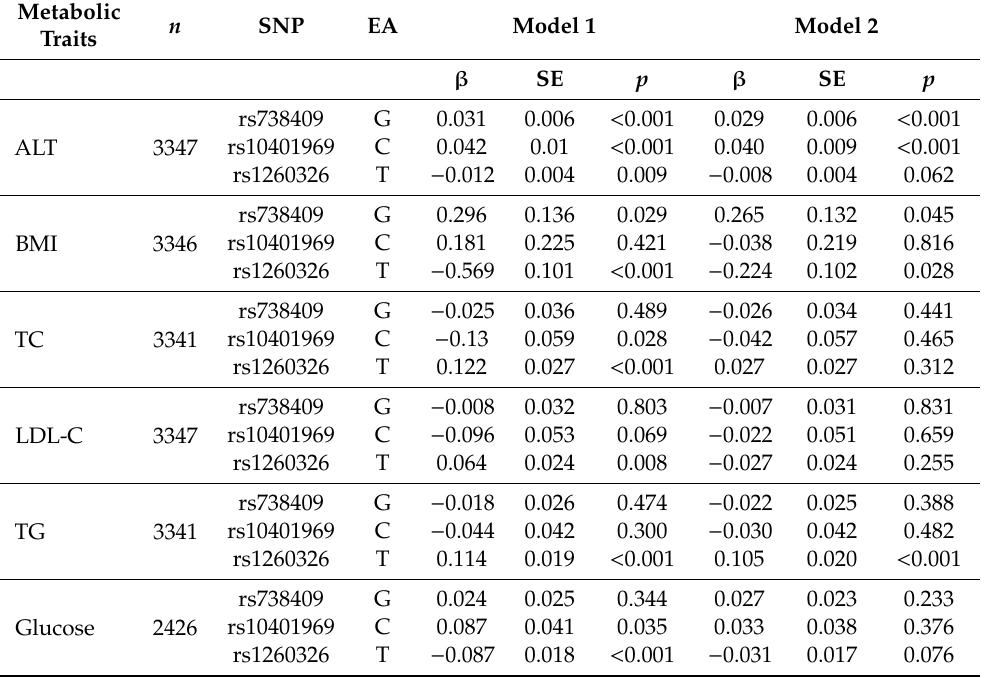
Table 3. Association of the e ff ect allele at rs738409 (C / G), rs10401969 (T / C), and rs1260326 (C / T) with metabolic